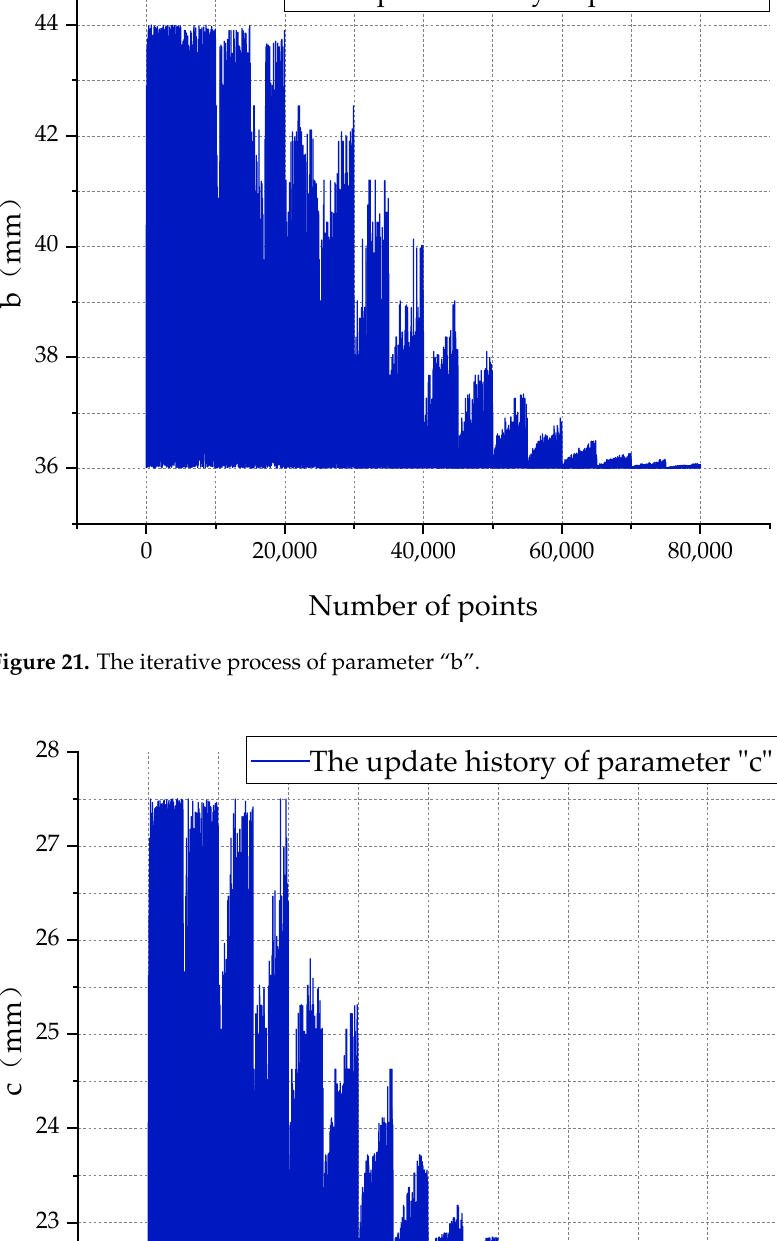
Figure 20. The iterative process of parameter “a”.